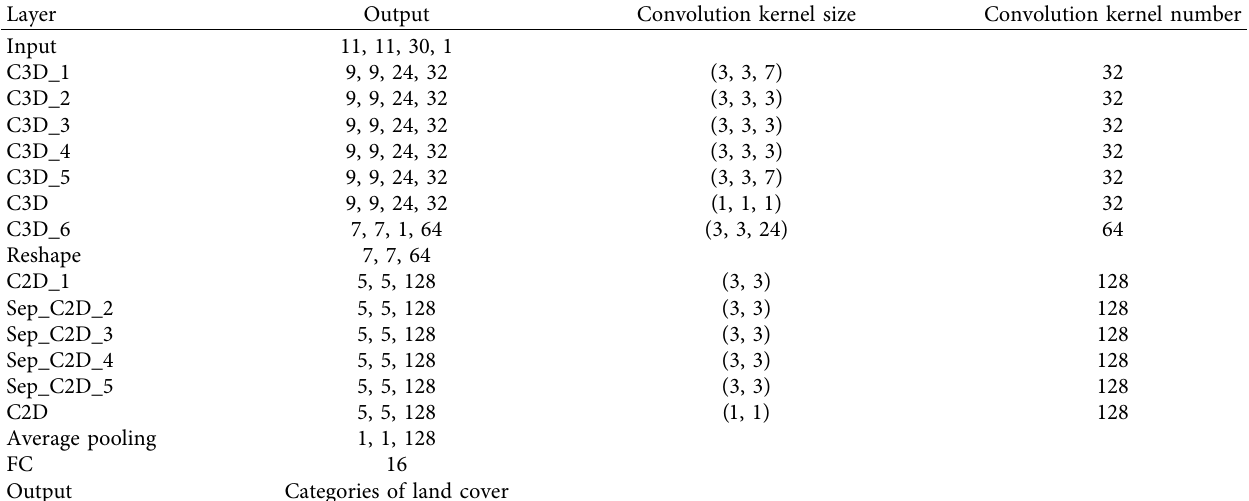
Table 1: The architecture of the proposed network.